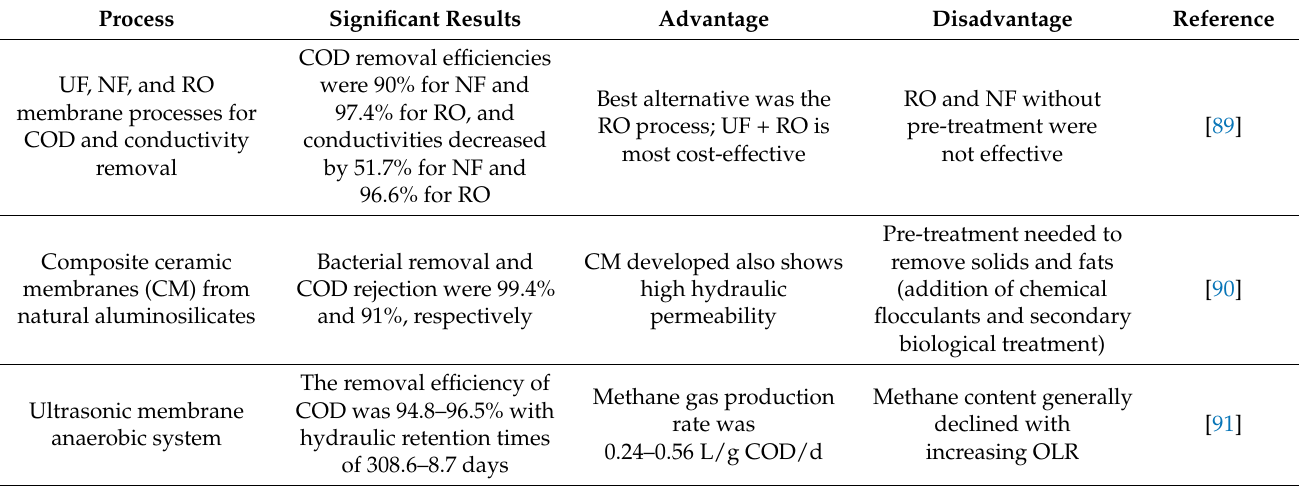
Table 3. Physical treatment methods for slaughterhouse wastewater. Abbreviations for common terms in table